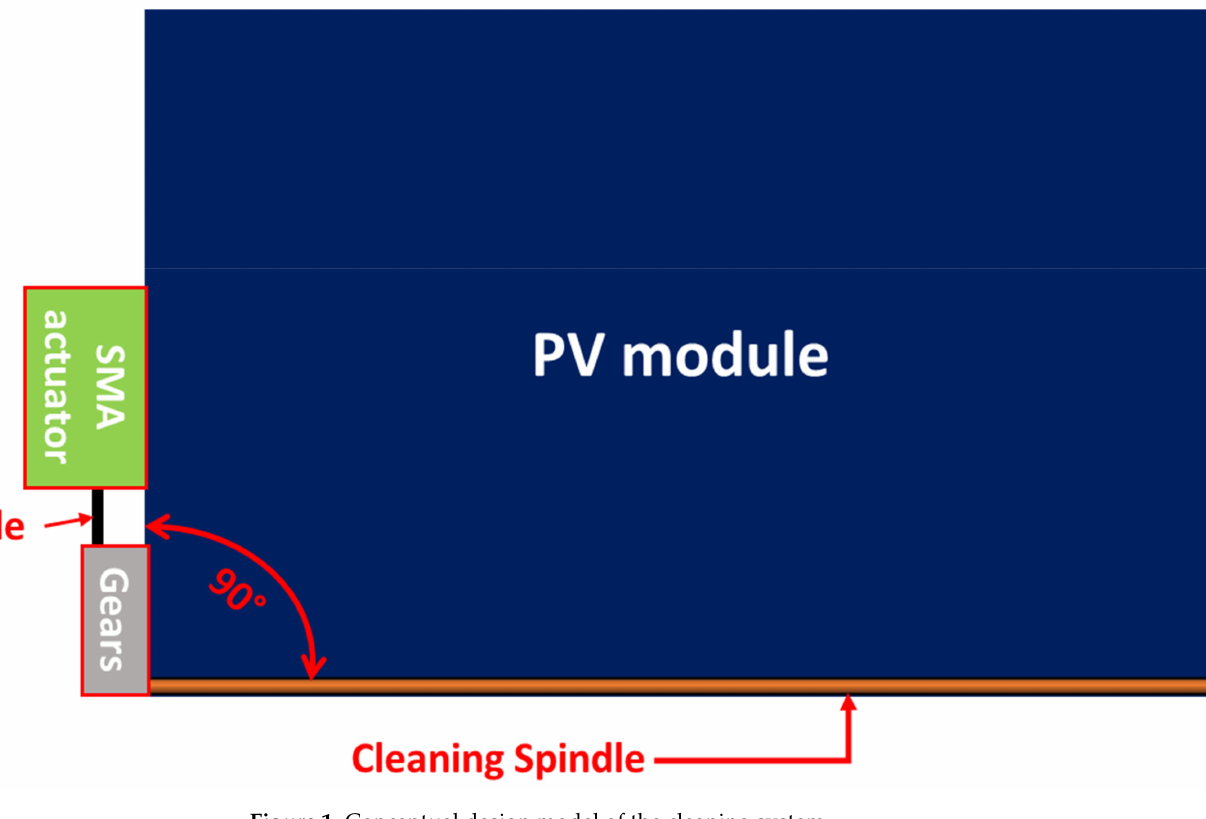
Figure 1. Conceptual design model of the cleaning